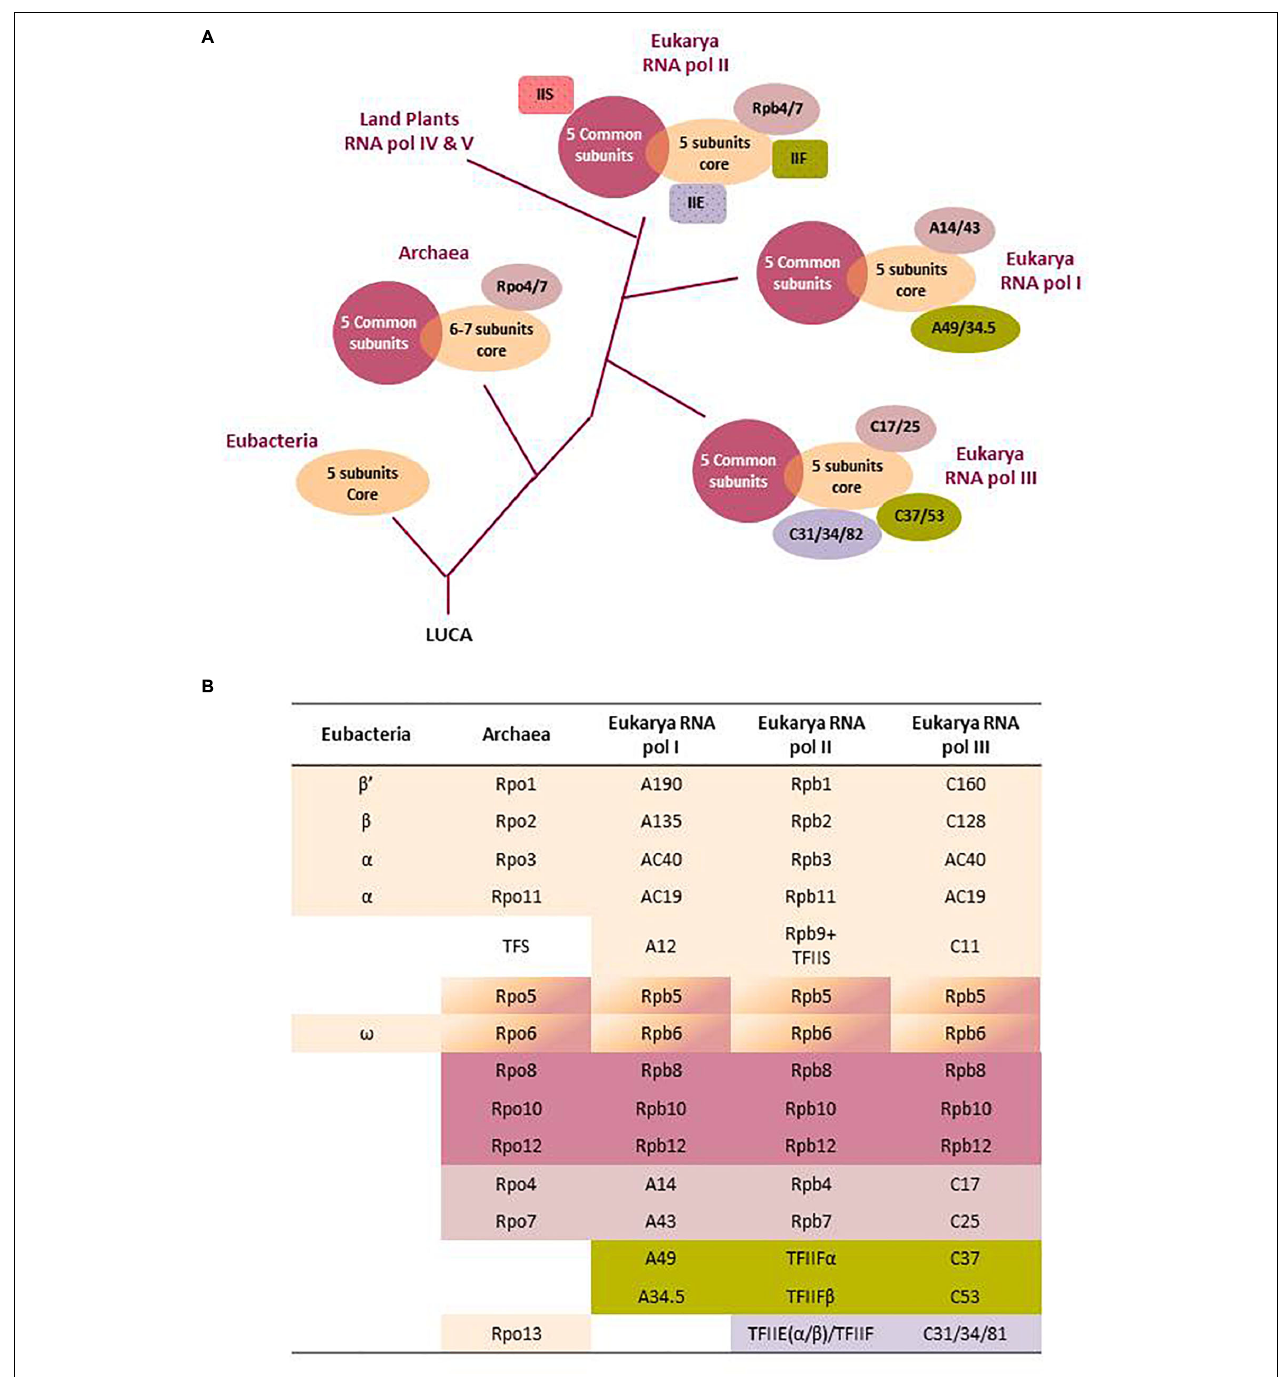
FIGURE 1 | Evolutionary history and subunit organization of nuclear eukaryotic RNA polymerases. (A) The last universal common ancestor (LUCA) of all organisms is assumed to have a multisubunit DNA-dependent RNA polymerase. Nowadays, all living beings have RNA pols with a core of five to seven subunits. After Eubacteria separation, the common ancestor of Archaea and Eukarya added additional peripheral subunits. Finally, after eukaryote emergence, the Archaea -derived nucleus started to develop specialized RNA polymerases. Specialized RNA pols I and III integrated some transcription factors as permanent subunits which, in RNA pol II, remain independent (TFIIS, TFIIF, TFIIE). RNA pol IV and V are not fully described. Only the branching after RNA pol I separation is indicated. See the main text for further descriptions. (B) The table shows a comparative scheme of the RNA pol subunits aligned according to sequence and/or functional homology. Colors correspond to the structural scheme of part (A) . Note that the Rpb5 and 6 subunits are part of both the core and the five unit sets of common subunits to all three eukaryotic RNA pols. Archaeal Rpo13 has no equivalent in eukaryotes, and the TFS from Archaea is an independent homologous factor to eukaryotic TFIIS. See Werner and Grohmann (2011); Vannini and Cramer (2012), and Huang et al. (2015) for more details on RNA pol subunit structure and evolution.